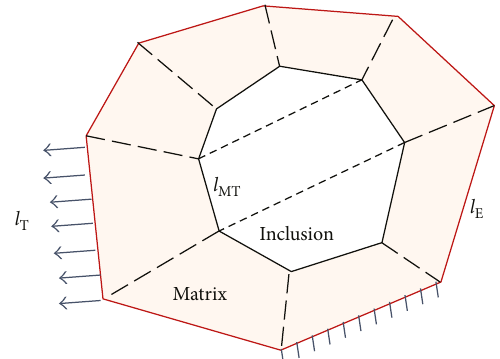
Figure 3: A typical Voronoi cell element with an octagonal